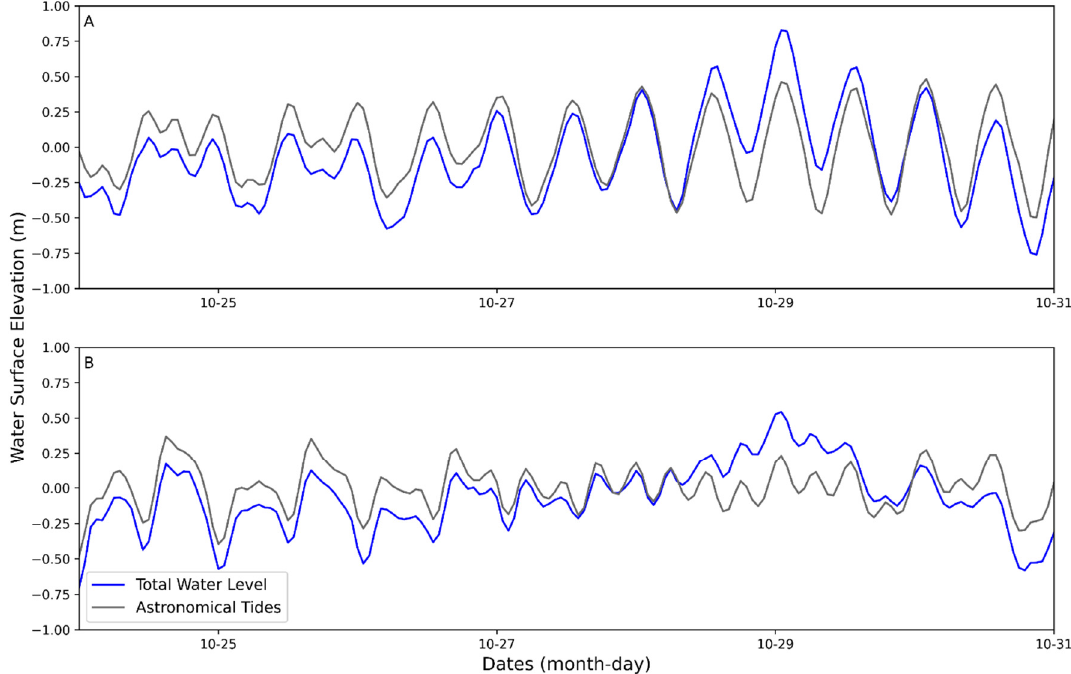
Figure 14. ( A ) Original TWL and Astronomical tides during Storm 1. ( B ) Scenario analysis considering the same event under different astronomical tides conditions.